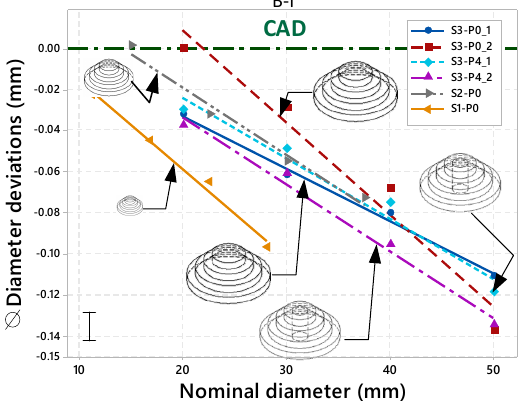
Figure 6. Intra-part scale effects of the Shape B artifacts carried out as-built, based on their cylinders’ diameters .